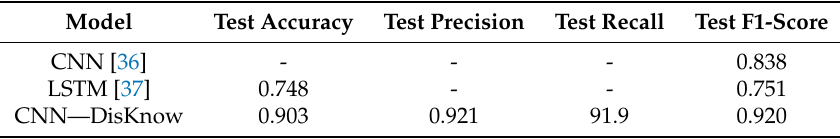
Table 1. Comparative results of the event relatedness classification